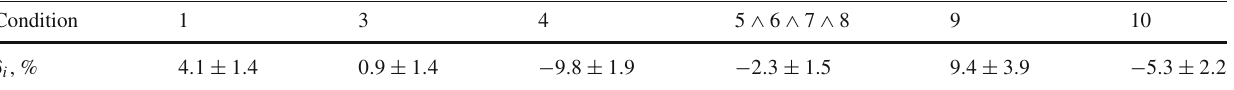
of the fit described in the text. The light-shaded (yellow) histograms show the fitted cosmic-ray background. The medium-shaded (green) regions at the left and middle plots represent the fitted beam-induced plus physical background